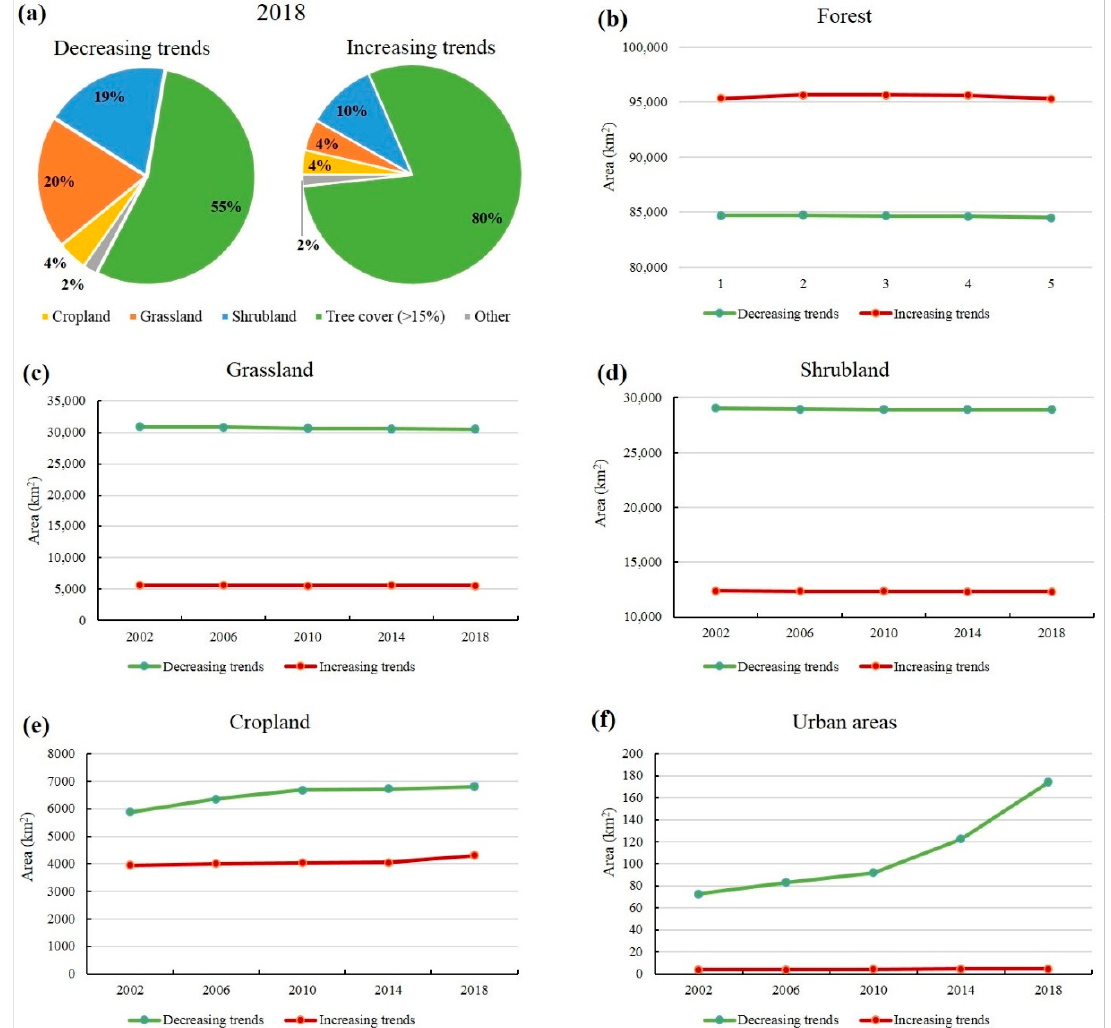
Figure 7. Land cover and the significant trends of burnt areas from 2002 to 2018, in increasing and decreasing trends clusters: ( a ) Proportions of the main land cover classes in 2018 (the last year for which information is available); ( b ) area of forest; ( c ) area of grassland; ( d ) area of shrubland; ( e ) area of cropland; ( f ) area of urban areas.